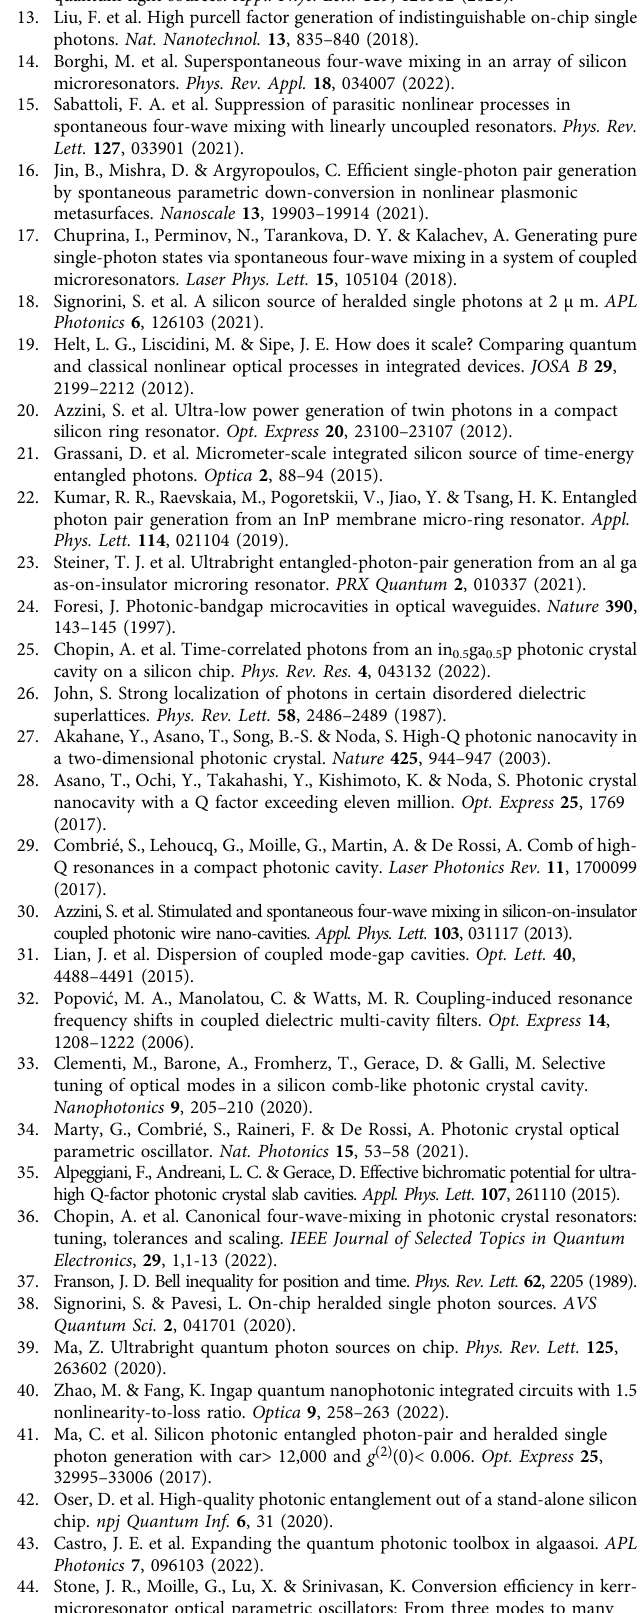
Table 3 Losses (in dB) on the signal and idler